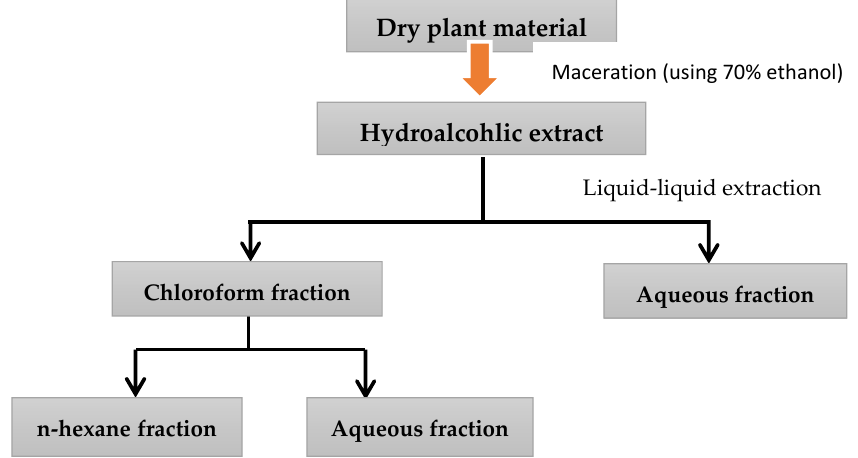
Figure 10. Steps of extract and fractions preparation.